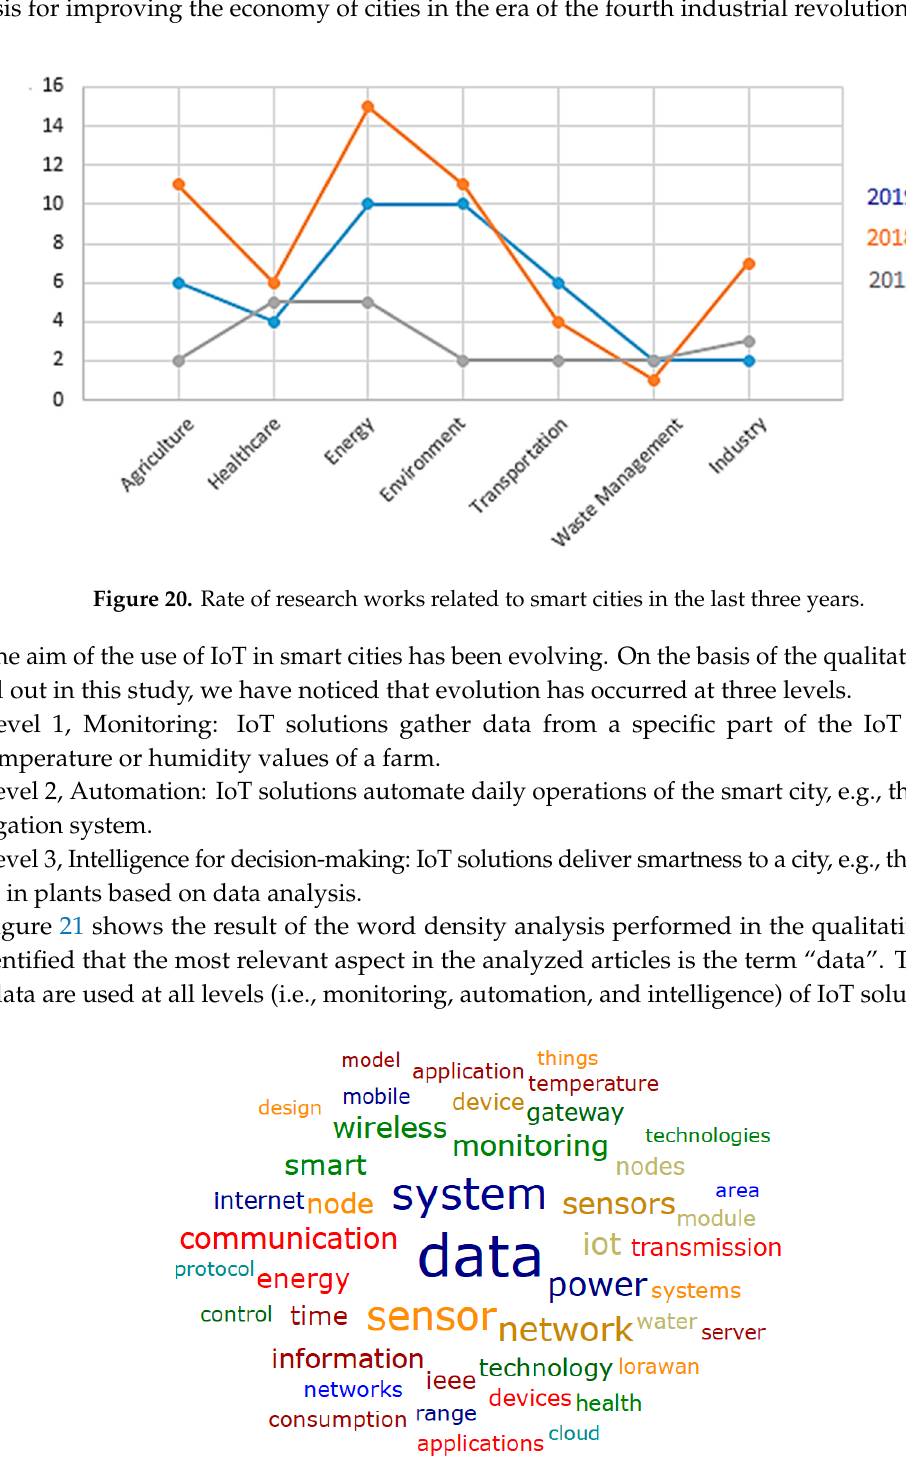
Figure 21. Word density analysis in LoRa publications from 2015 to 2019.